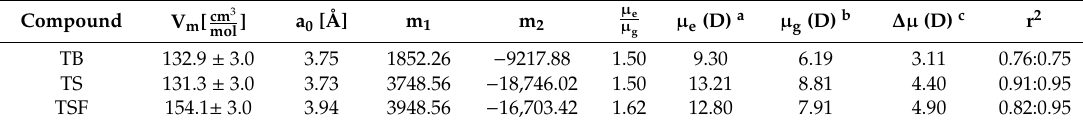
Table 2. m 1 and m 2 determined by Stokes shift against function F ( ε , n ), and m 2 determined by ( v a + v f ) against F ( ε , n ) + 2 g ( n ), ground state µ g , excited state µ e , change in dipole moment ∆ µ , and